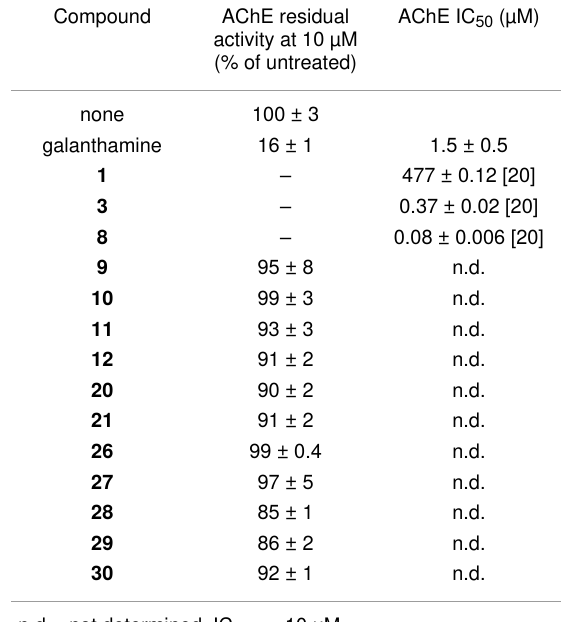
Table 1: Inhibition of acetylcholine esterase by the synthesized ana- logues. Compound AChE residual activity at 10